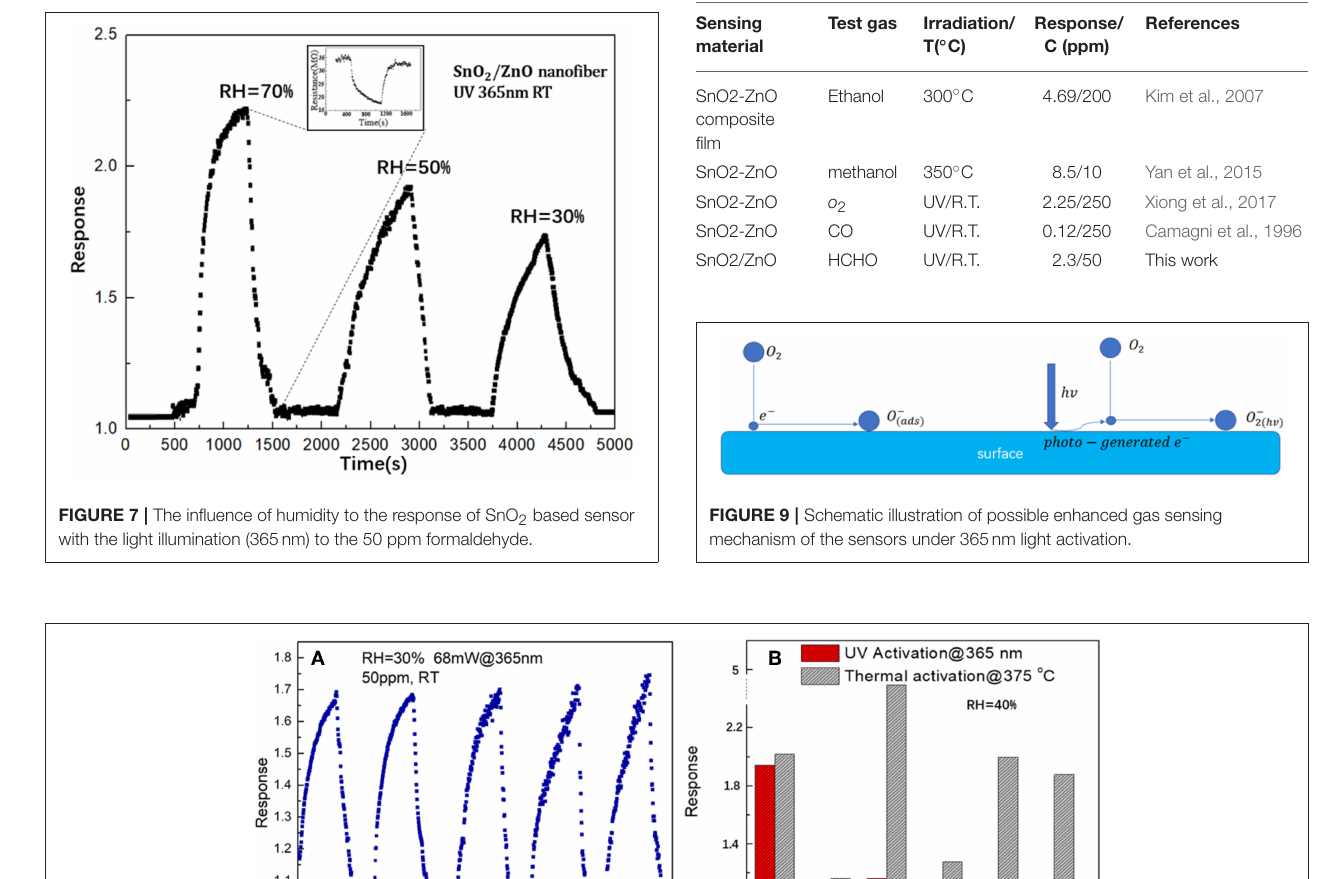
TABLE 2 | Comparison of the gas sensing properties of SnO 2 based heterojunctions.